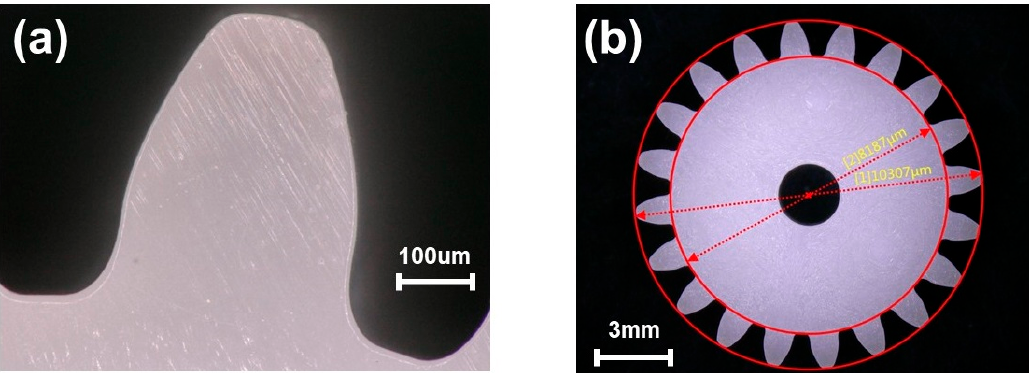
Figure 8. ( a ) The tooth morphology of the gear sample. ( b ) Key dimension results of experiment under reference process parameters. Table 5. Comparison of key dimension shrinkage rates obtained by simulation and experiment.